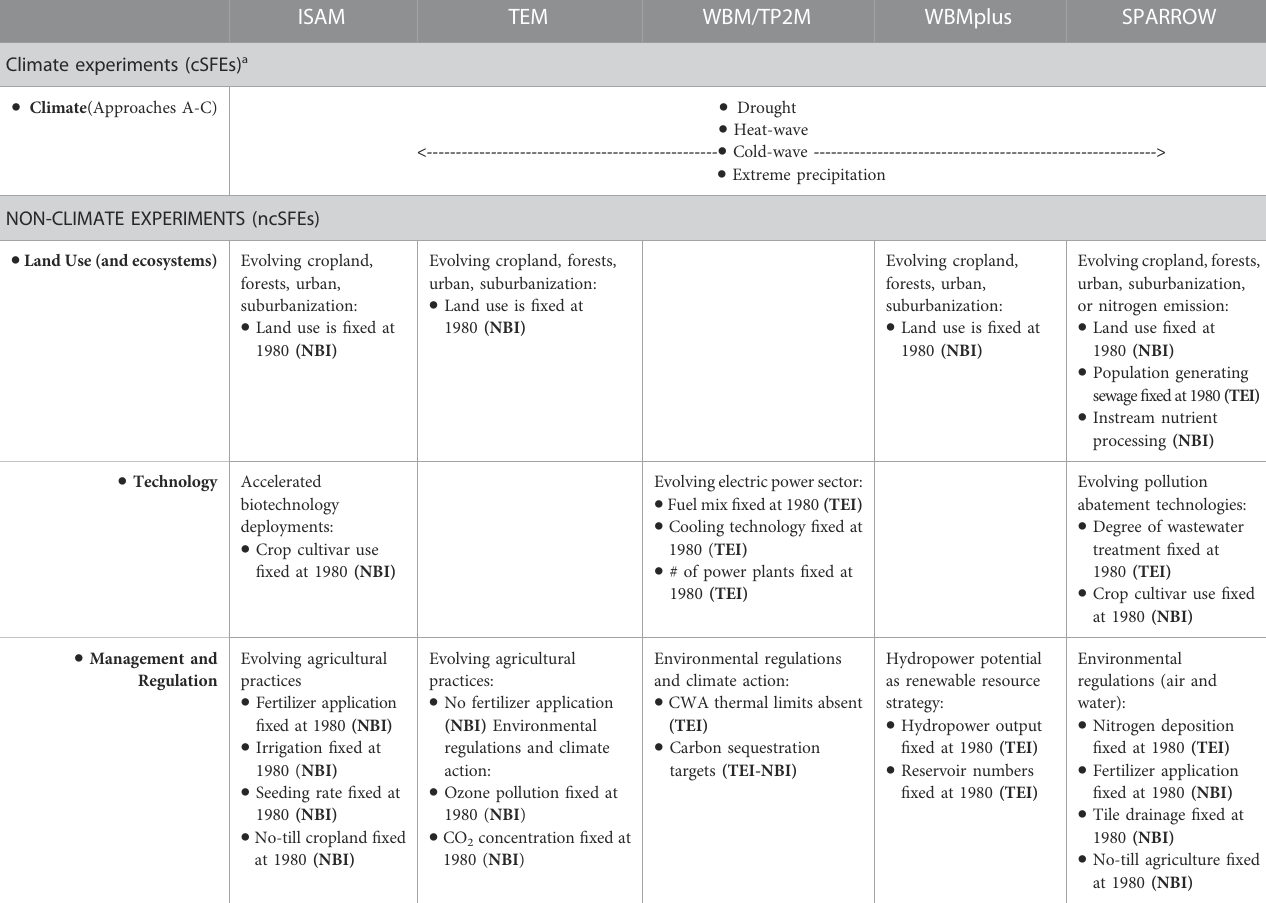
TABLE 2 The four main categories of FEWS elements manipulated using the Single Factor Experiments, expressed for climate (cSFEs) and for non-climate entities (ncSFEs), and dedicated to uncovering FEWS sensitivities. For the ncSFEs, each subordinate entry de fi nes a particular variable that is fi xed at 1980 levels while the baseline otherwise progresses as in the historical time series (i.e., with all other elements varying as observed). The resulting time series of assessment model output variables under the scenario can then be compared to baseline. The sensitivity of any assessment model variable or collection of variables to a single or multiple perturbation canbe computed using Δ statistics as described, using speci fi c examples,in Supplementary Appendices S1 – S3.Relevancy to engineeredor nature-based infrastructure is